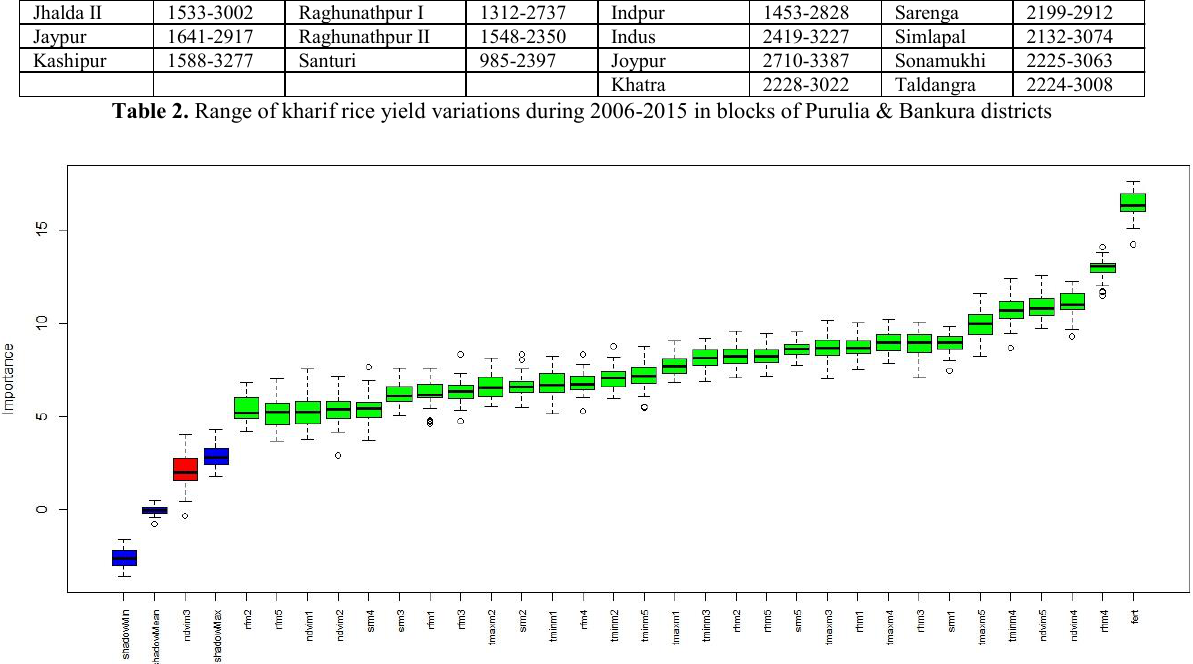
Figure 2. Boruta results box plot for Purulia and Bankura districts monthly NDVI, weather variables and Fertilizer for all relevant feature selection. Blue box plots correspond to minimal, average and maximum Z score of shadow variable. Green box plots represent Z scores of confirmed variables. Red box plot represents rejected variable. The top ranking relevant variables with decreasing rank are fertilizer, RH (Sept), NDVI (Sept), NDVI (Oct), TM (Sept), TX